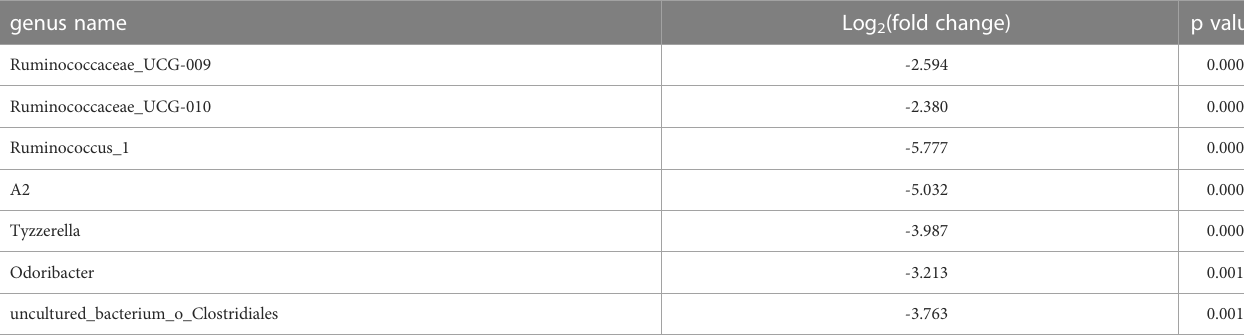
TABLE 2 Signi fi cantly changed gut microbiota between LGZG and NASH groups. genus